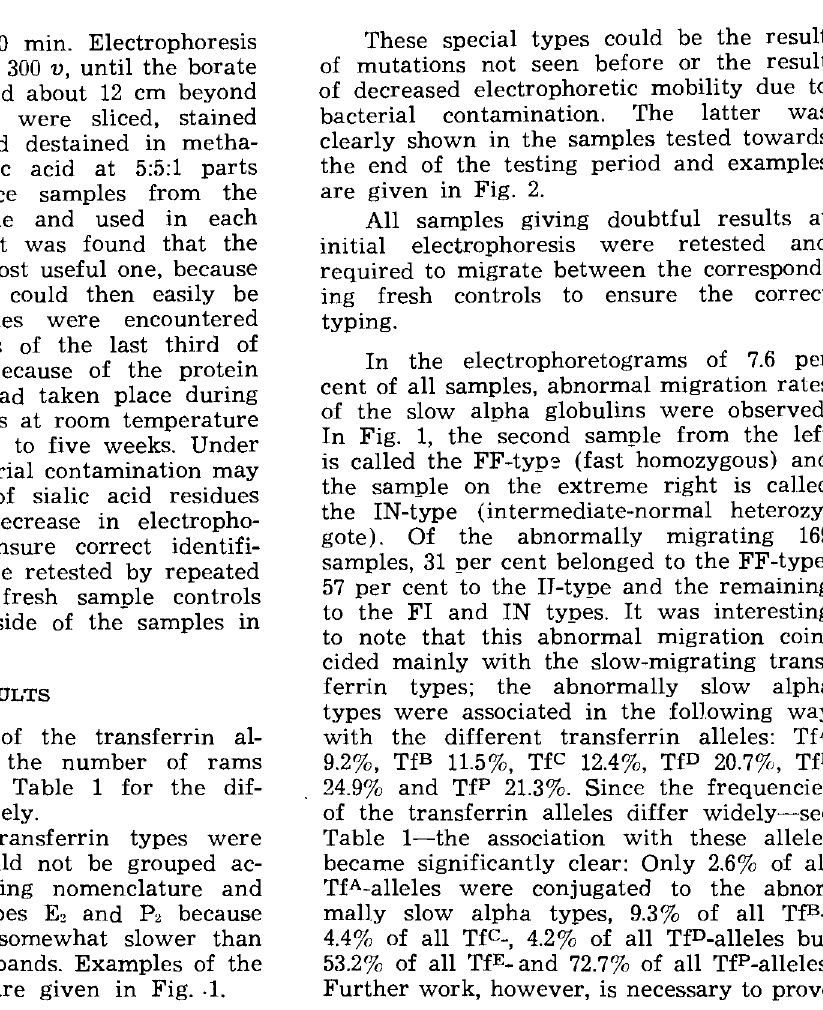
Table I: FREQUENCIES OF THE DIFFERENT TRANSFERRIN ALLELES IN DIFFERENT MAGISTERIAL DISTRICTS IN THE KAROO